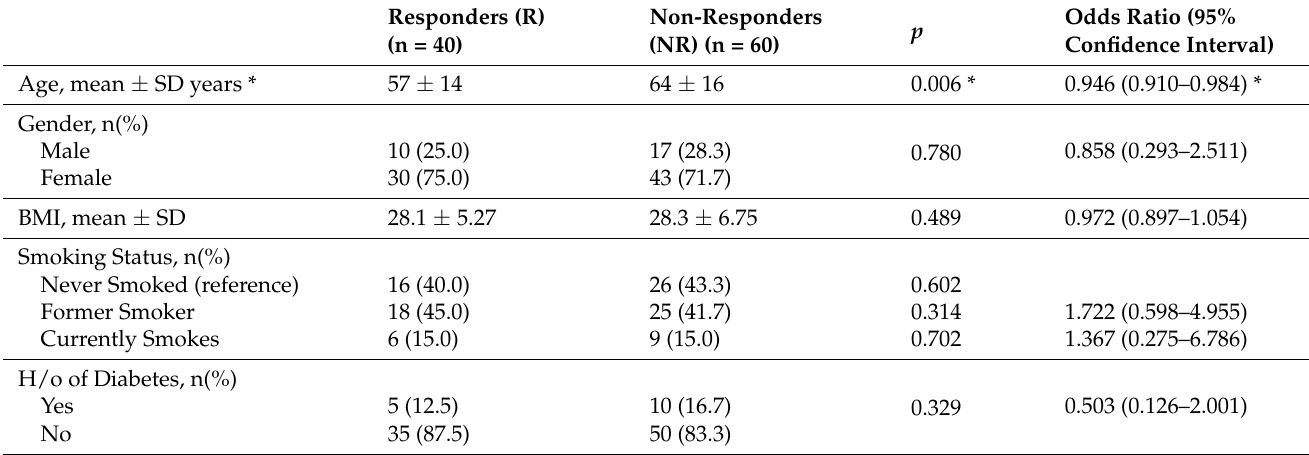
Table 3. Demographic variables and comorbidities investigated as